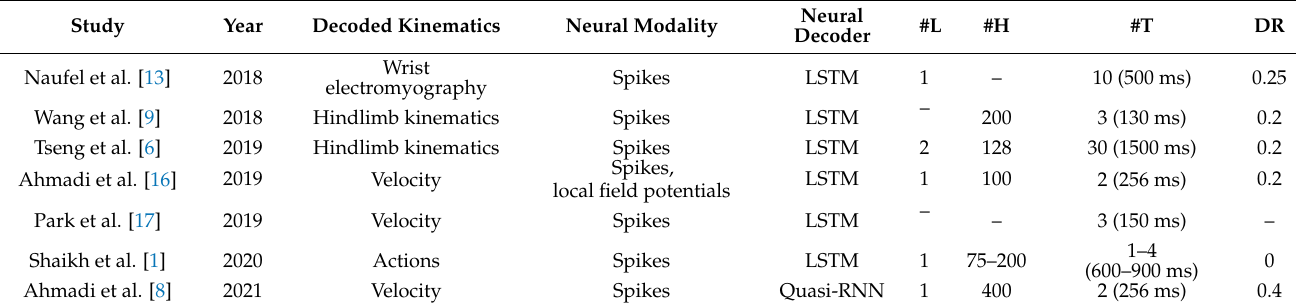
Table 1. Summary of existing iBCIs that use RNNs as neural decoders. The iBCIs were implemented for a nonhuman primate model. The time windows corresponding to the number of timesteps is given in parentheses in column #T. In [1], the number of hidden states and timesteps were optimized over a predefined range. (GRU, Gated recurrent unit; #L, Number of layers; #H, Number of hidden units; #T, Number of timesteps; DR: Dropout